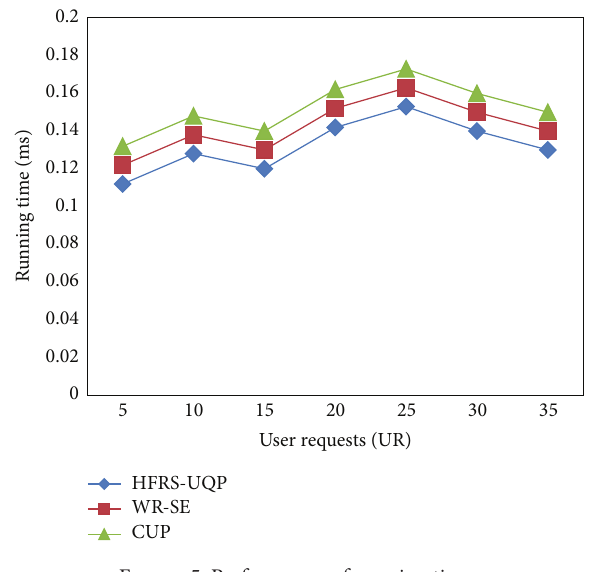
Figure 5: Performance of running time.